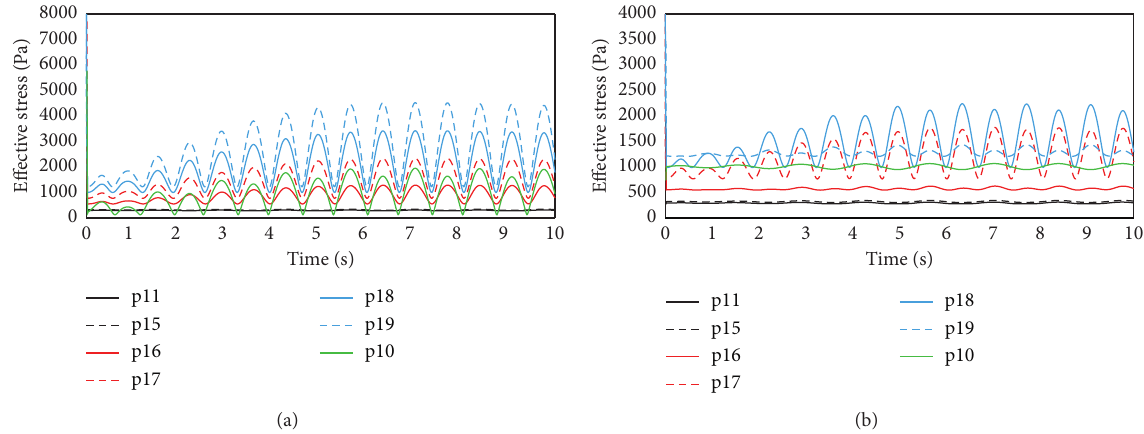
Figure 14: Comparison of effective stress in the vertical direction of different baffles: (a) tank with T-type baffle; (b) tank with double-side curved baffle.